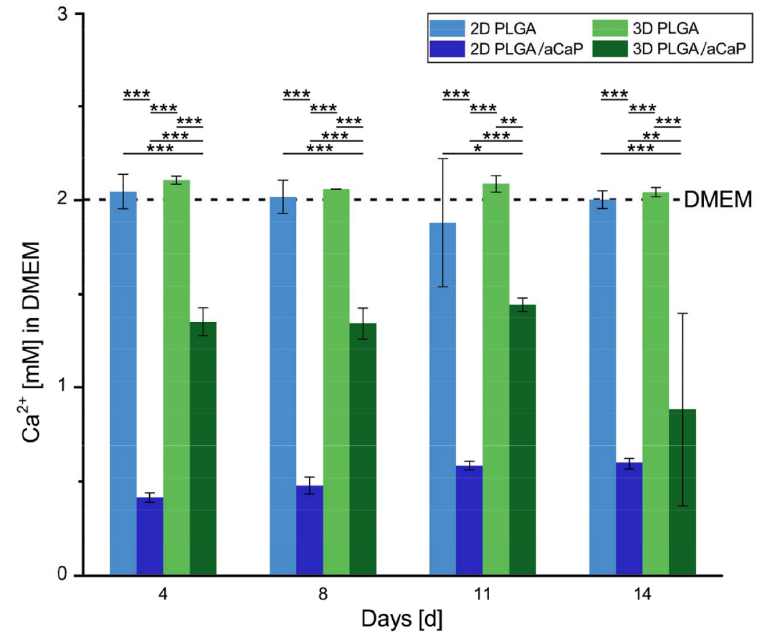
Figure 4. Ca 2+ ion concentration of DMEM medium exposed to either PLGA or PLGA/aCaP random fiber meshes and films. On PLGA / aCaP materials, calcium ions are reduced in 2D film to 0.5 mM and in 3D electrospun meshes to 1.3 mM. The p -values of pairwise comparison of one-way ANOVA statistics were considered significant if p < 0.05, denoted by *. **, p < 0.01; ***, p <